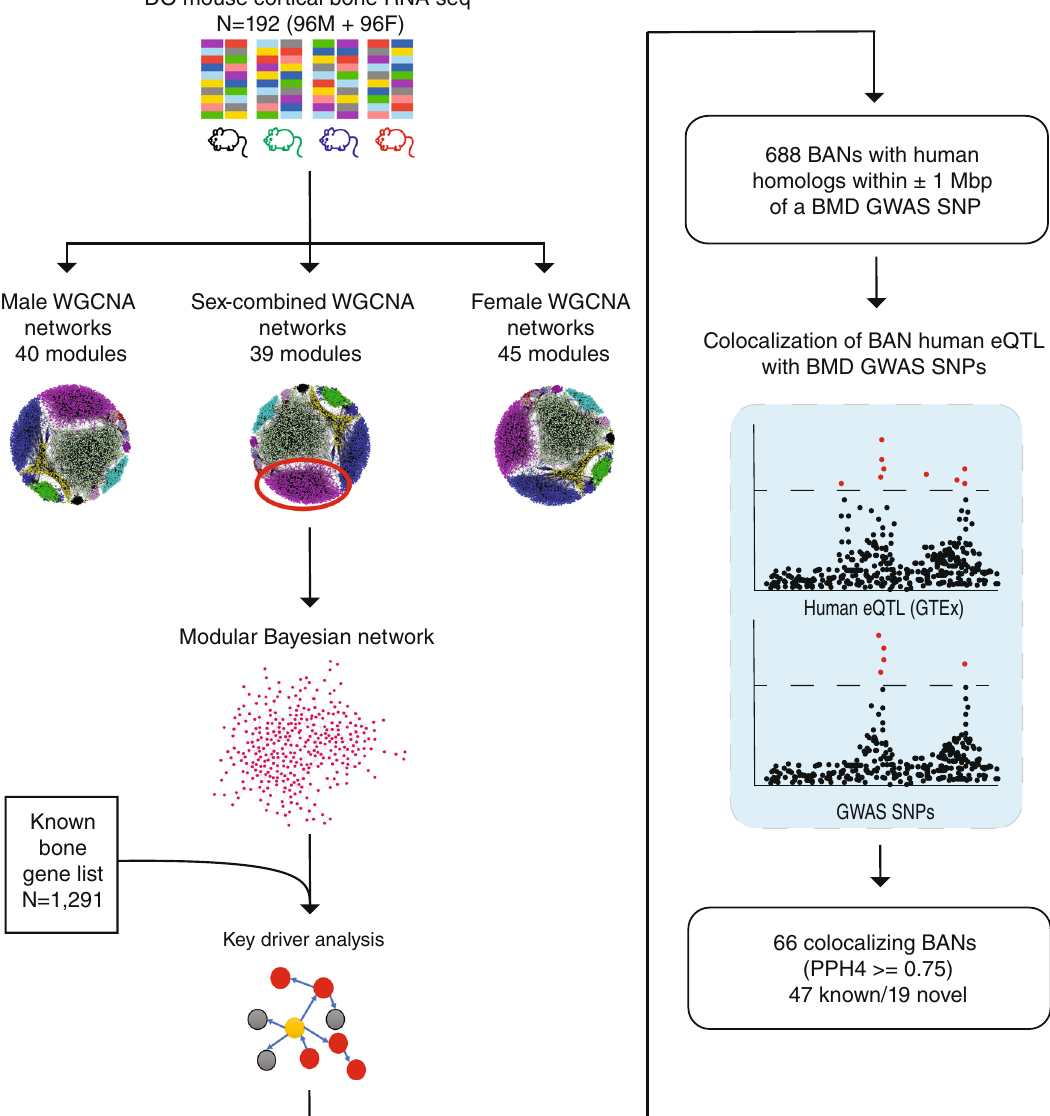
Fig. 3 Overview of the network approach used to identify genes potentially responsible for BMD GWAS loci. Three WGCNA networks (124 total modules) were constructed from RNA-seq data on cortical bone in the DO ( N = 192). A Bayesian network was then learned for each module. We performed key driver analysis on each Bayesian network to identify BANs, by identifying nodes (genes) that were more connected to more known bone genes than was expected by chance. We colocalized GTEx human eQTL for each BAN with GWAS BMD SNPs to identify potentially causal genes at BMD GWAS loci. For the key driver analysis, the yellow node indicates the queried gene, red nodes indicate known bone genes, and gray nodes indicate non- bone genes. DO diversity outbred, WGCNA weighted gene co-expression network analysis, BAN bone-associated nodes, eQTL expression quantitative trait loci, BMD bone mineral density, GWAS genome-wide association studies, SNP single-nucleotide polymorphism, PPH4 posterior probability of colocalization, hypothesis